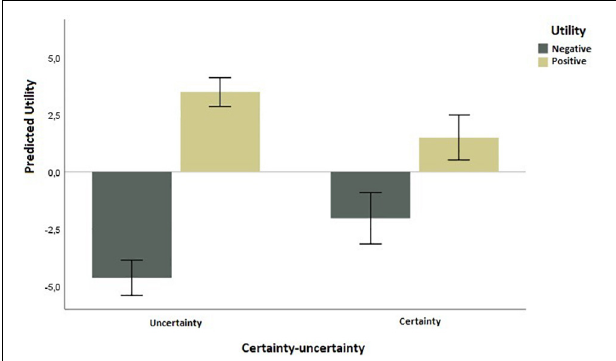
FIGURE 3 | On the interaction effect of certainty–uncertainty and type of utility on predicted utility, for both positive and negative